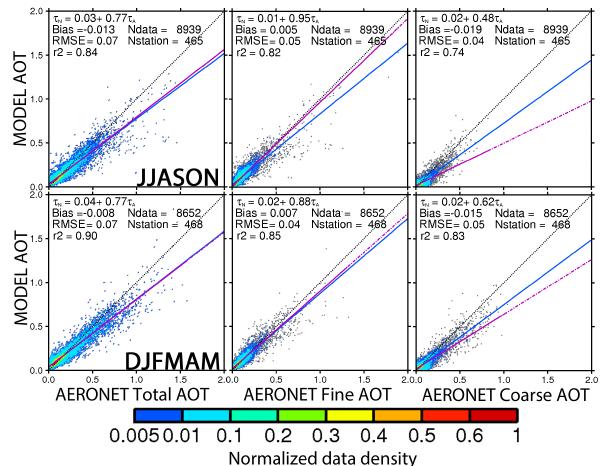
Figure 8. Same as Fig. 7, except for the monthly average of pairwise 6-hourly mode AOTs at 550nm. Monthly average is obtained only when the total number of 6-hourly AERONET data exceed 10 to ensure temporal representativeness. The monthly average reanalysis AOT here is calculated based on the available 6-hourly data that can be paired with AERONET